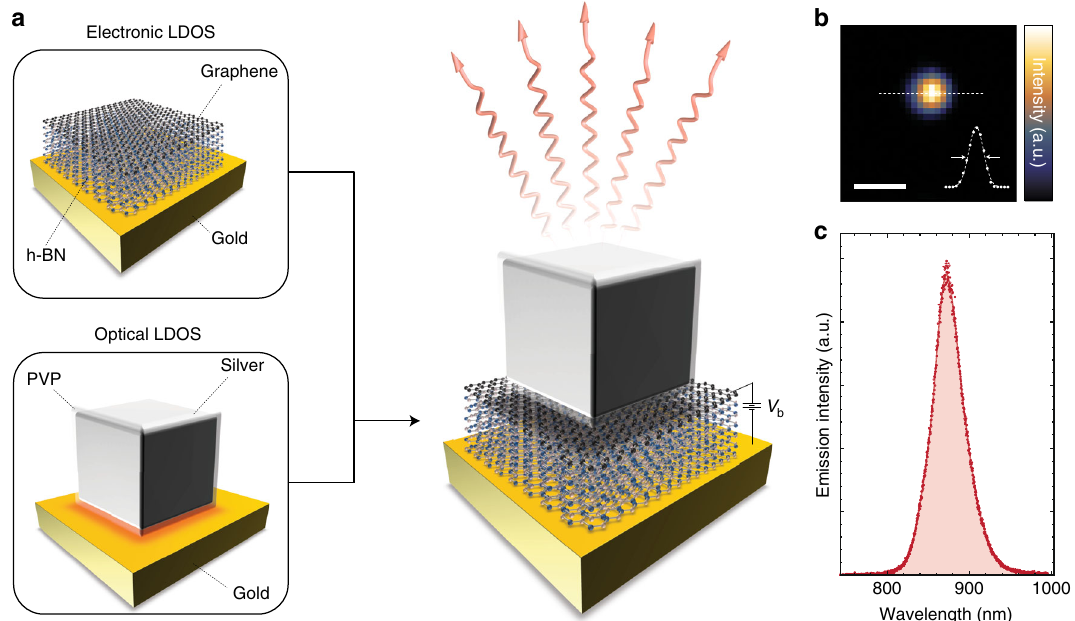
Fig. 1 Visualization of the vdWQT device concept. a Illustration (not to scale) of a gold – few-layer h-BN – graphene vdWQT device, integrated with a (silver, PVP-coated) nanocube antenna. In this device con fi guration, the electronic LDOS is controlled by the hybrid vdW heterostructure whereas the optical LDOS is governed by the nanocube antenna. Applying a voltage V b across the insulating few-layer h-BN crystal results in antenna-mediated photon emission (wavy arrows) due to quantum tunneling. b , c Measured spatial ( b ) and spectral ( c ) photon distribution from a nanocube antenna coupled to a vdWQT device, demonstrating a diffraction-limited spot and a narrow emission spectrum. The inset in b shows a line-cut, featuring a line-width (FWHM) of ~460 nm, close to the expected value of λ /(2NA) ~ 480 nm. Scale bar: 1 μ